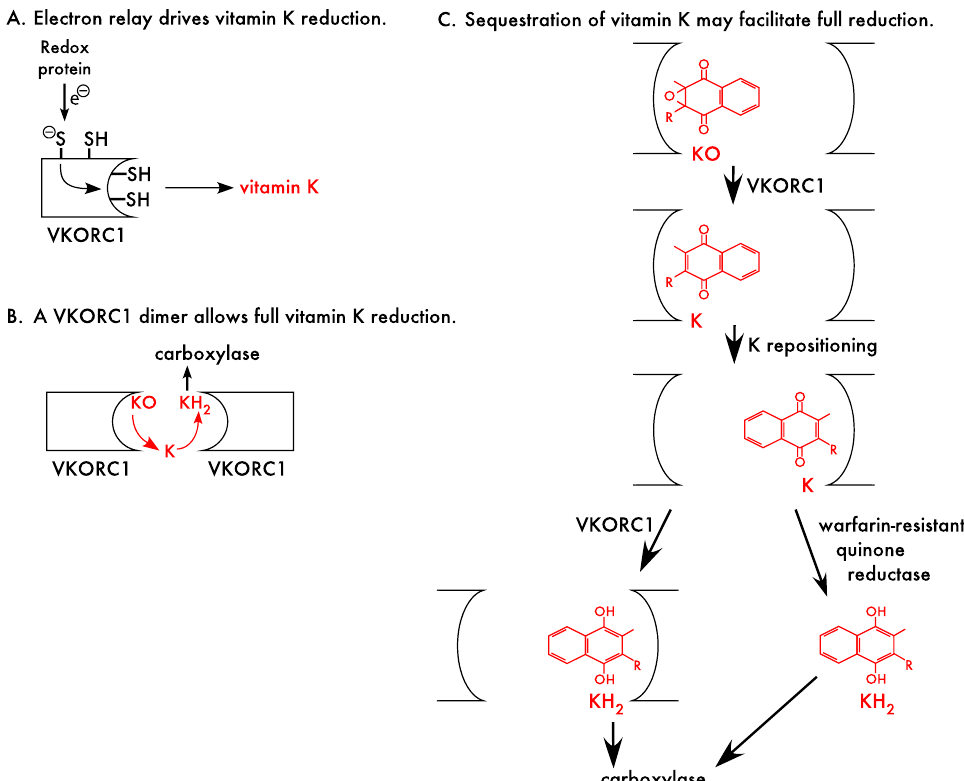
Figure 4. VKORC1 reduces vitamin K epoxide, and is inhibited by warfarin. ( A ) VKORC1 reduces vitamin K through an electron (e − ) relay pathway. Redox protein generates thiols in VKORC1 located in the endoplasmic reticulum, which in turn generate membrane-embedded thiols that reduce vitamin K. ( B ) VKORC1 reduction of vitamin K epoxide (KO) to the vitamin K hydroquinone (KH 2 ) carboxylase cofactor occurs in two reactions that involve a vitamin K quinone (K) intermediate. VKORC1 exists as a dimer [75], which can explain how VKORC1 performs both reactions. ( C ) Sequestration of the K intermediate may increase the efficiency of VKD protein carboxylation [75]. One monomer converts KO to the K intermediate, which is then repositioned for further reduction to KH 2 by the second monomer. Warfarin uncouples the two VKORC1 reactions [76], which alters full reduction by inhibiting the K to KH 2 reaction much more strongly that the KO to K reaction. Full reduction during warfarin therapy may therefore result from a second reductase cooperating with VKORC1 to generate the KH 2 carboxylase